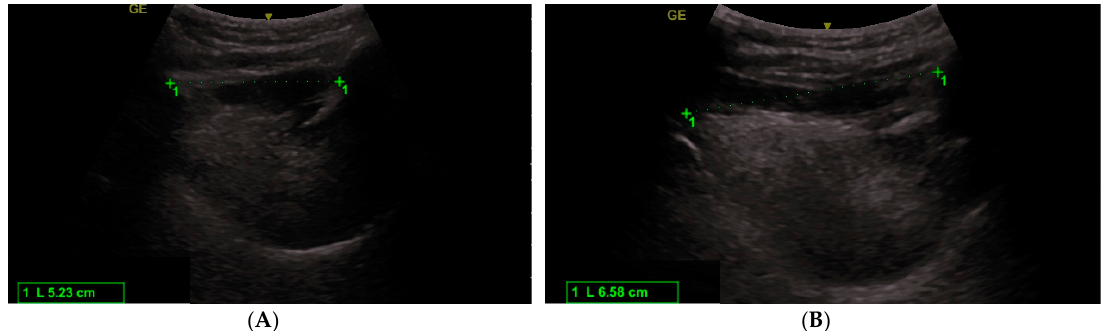
Figure 1. Ultrasound measurement of the hyomental distance in neutral position ( A ) and maximal hyperextended position ( B ).